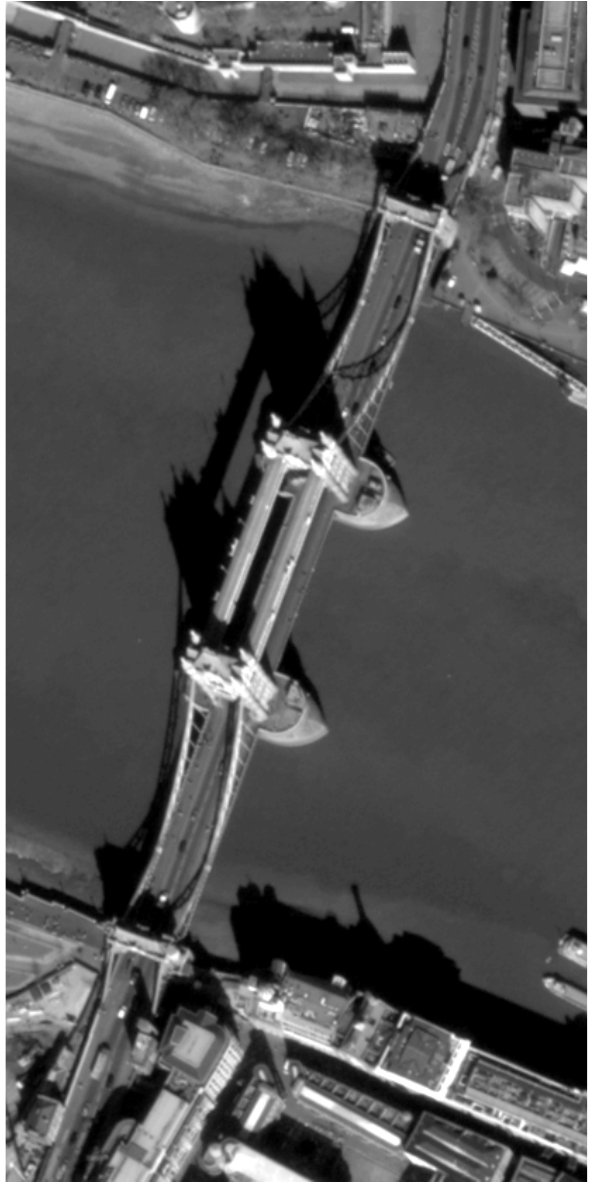
Figure 1 : WorldView-2 image of the London tower bridge. MS image at source resolution. Courtesy of Digital Globe.